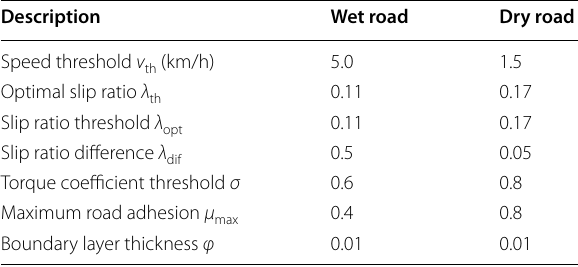
Table 4 Parameters of the controller in vehicle